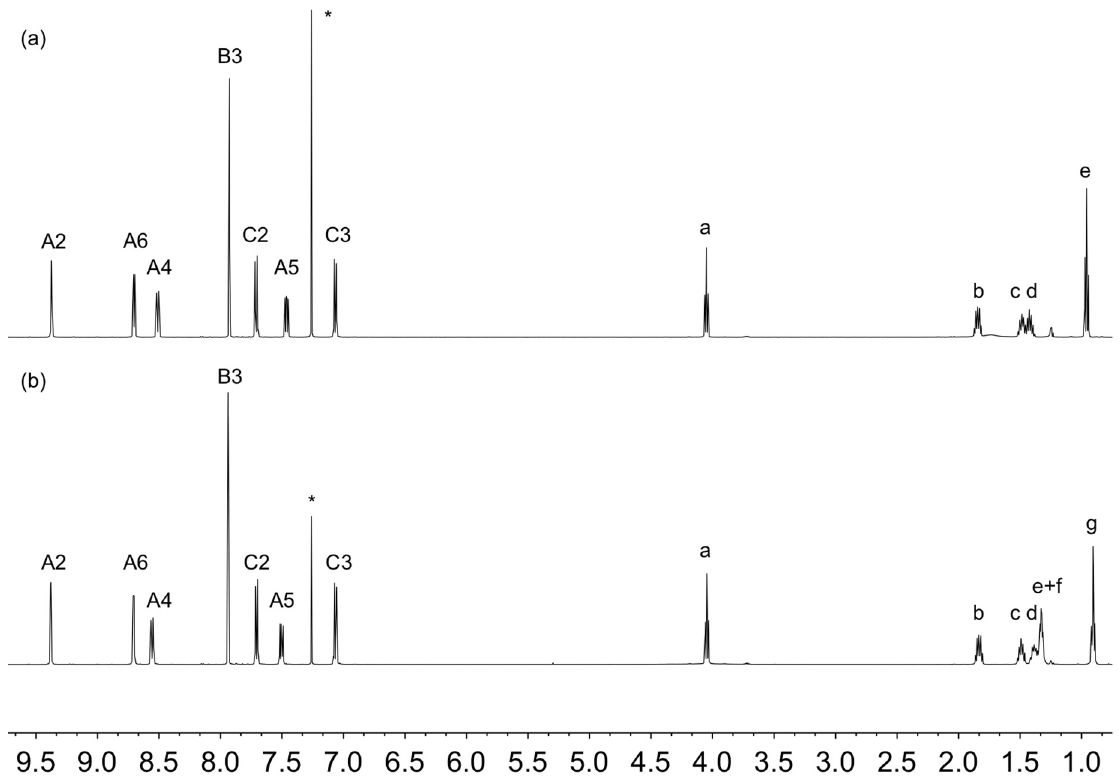
Figure 1. The 1 H (500 MHz, CDCl 3 , 298 K) NMR spectra of ( a ) 3 and ( b ) 4 . * = residual CHCl 3 . See Scheme 4 for atom labelling.